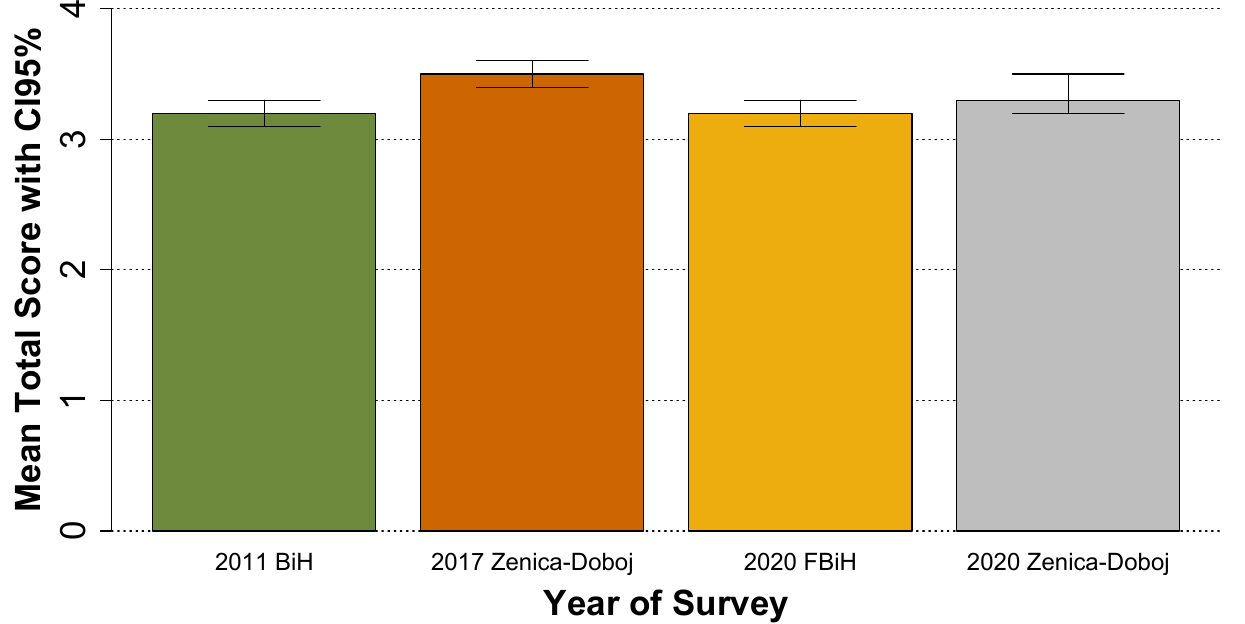
Figure 1. Satisfaction with health care in the adult population of the Federation of Bosnia and Herzegovina and the Zenica-Doboj region in 2011, 2017, and during the COVID-19 pandemic. Source of data for 2011 and 2017 [13].